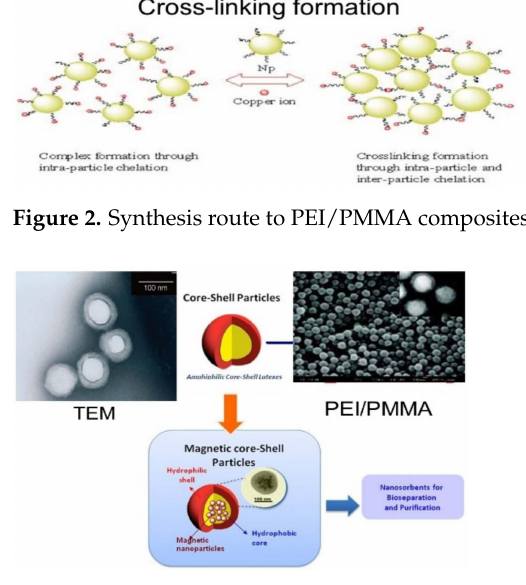
Figure 3. PEI/PMMA adsorbents for wastewater